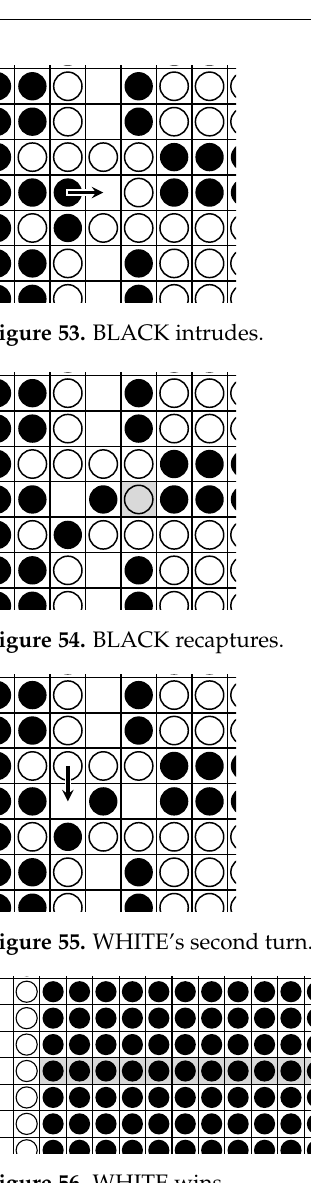
Figure 56. WHITE wins. Notice that BLACK’s invasion of the checkmating square forces his defeat shown in Figures 57–60.